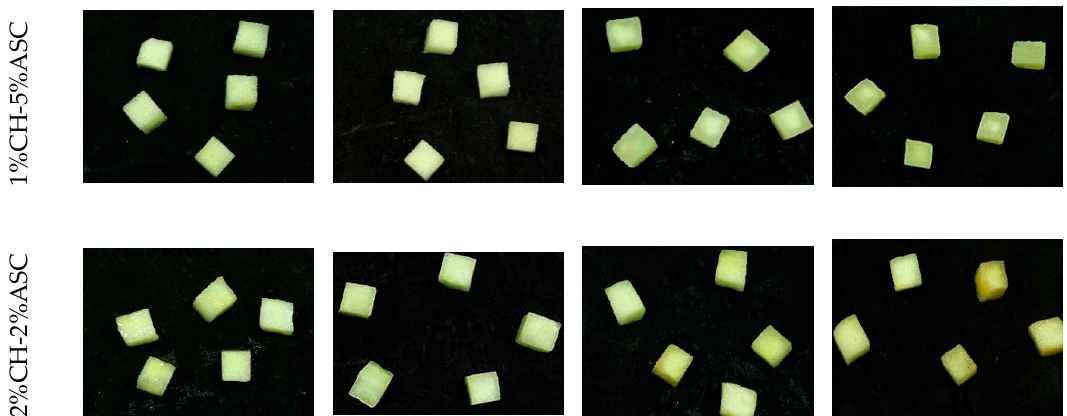
Figure 2. Images of fresh-cut apples after coating and storing at 5 °C for days 0, 3, 7 and 14.